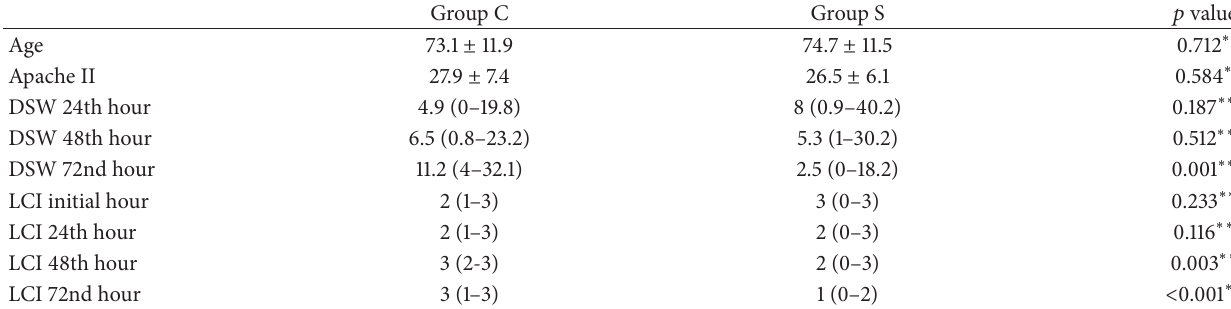
Table 1: Demographic, DSW, and LCI data.